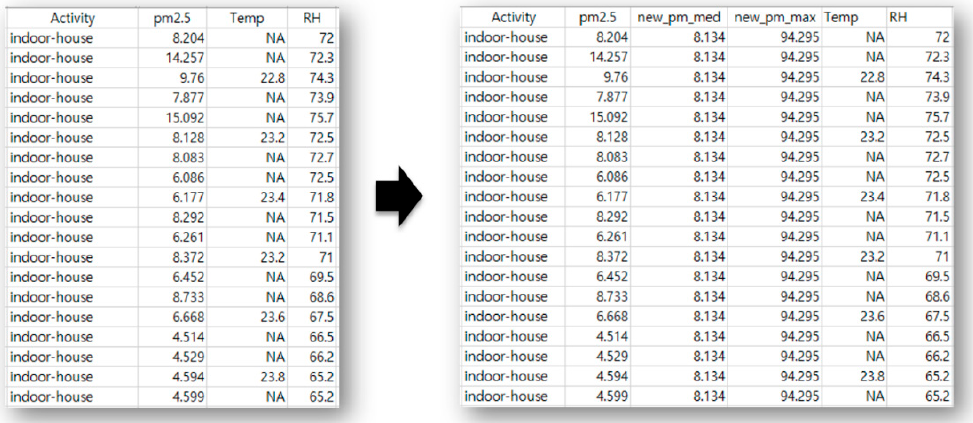
Figure 1. Snapshot of training data before (on the left-hand side) and after (on the right-hand side) the data transformation. The median (new_pm_med) and the maximum (new_pm_max) values of PM 2.5 were used as features.